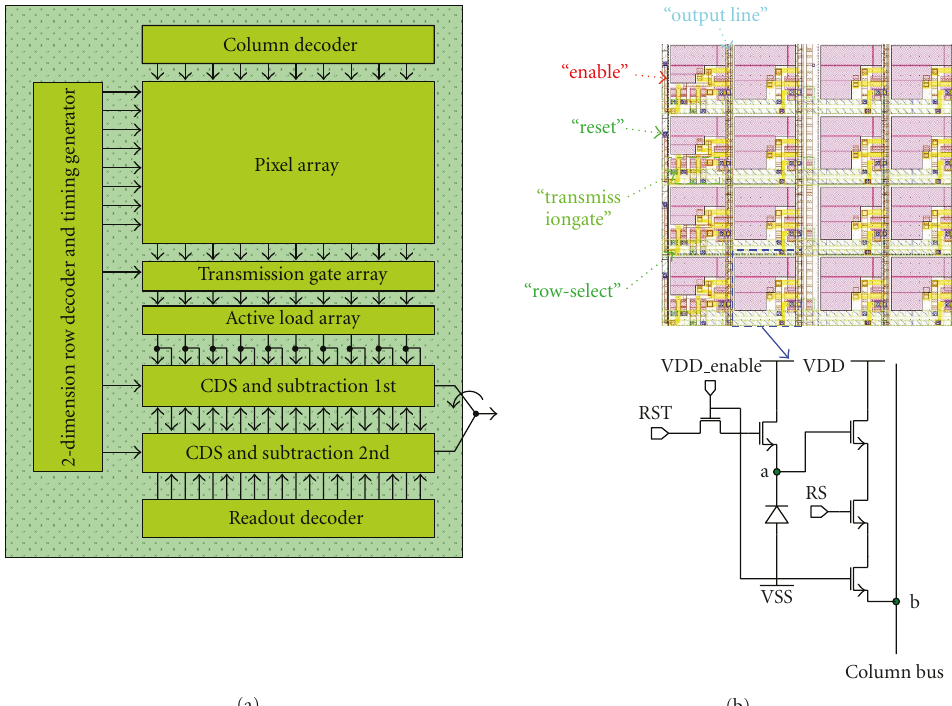
Figure 2: (a) The structure of locally raster-scanning raw image sensor. (b) The pixel sensor architecture for the locally raster-scanning raw image